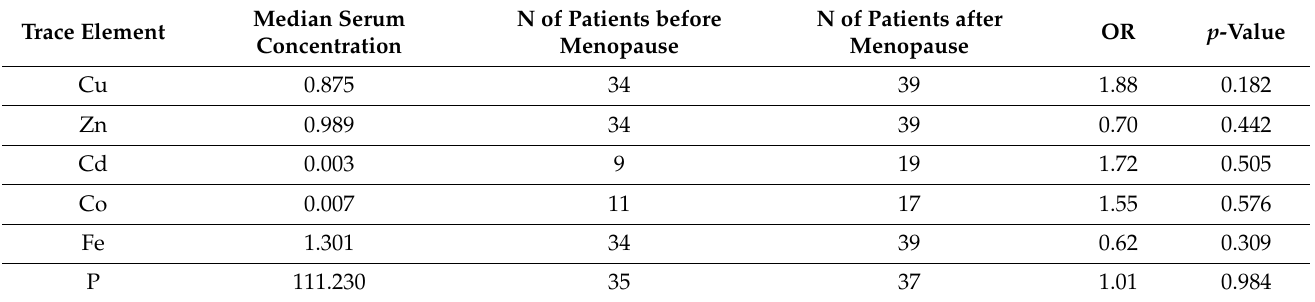
Table 3. Serum metalloestrogen concentration in pre- and postmenopausal patients.